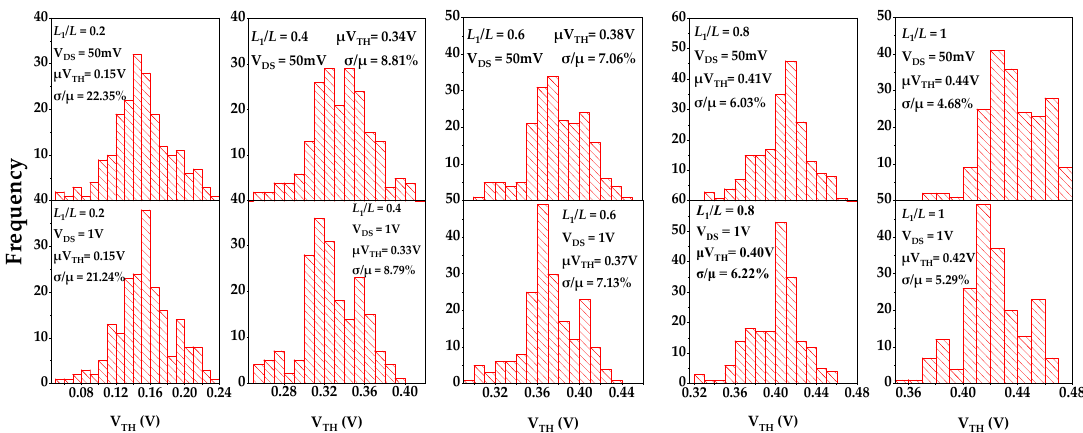
Figure 3. Frequency distribution of V TH with different L 1 / L at V DS = 0.05 V and 1 V.